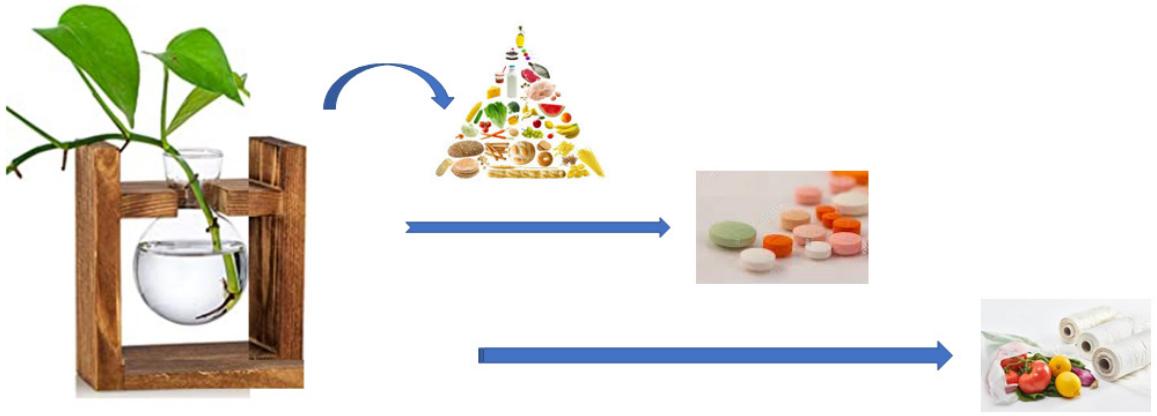
Figure 1. Plants as the primary source of everything we need .